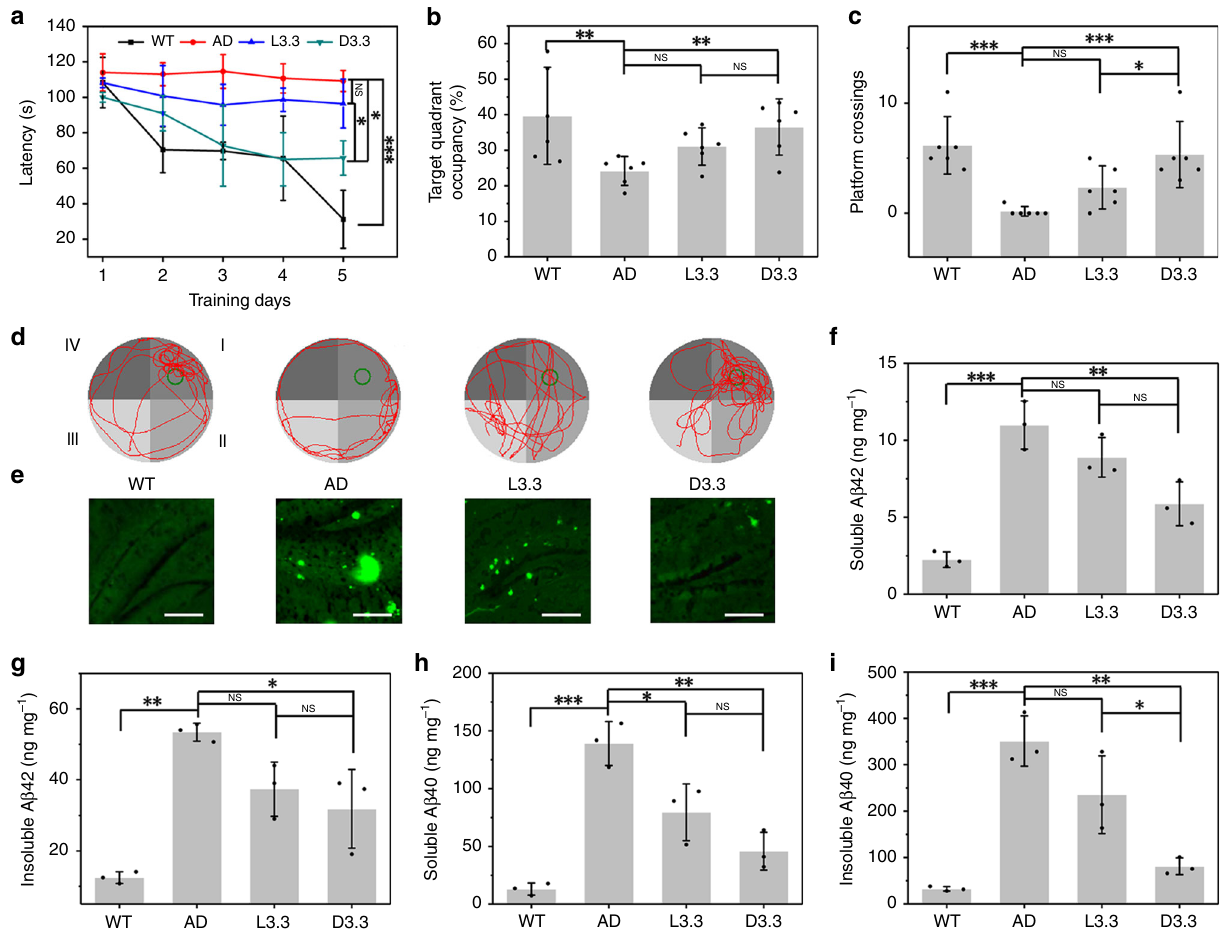
Fig. 5 Effect of L3.3 and D3.3 on rescuing memory impairments in AD model mice. a Latency for escape to platform in the training phase. b Percentage (%) of time spent in the target quadrant in probe test. c Number of crossing platform time in probe test. Error bars indicate the s.d. ( n = 6 mice per group). * P < 0.05; ** P < 0.01; *** P < 0.001; NS not signi fi cant; one-way ANOVA, followed by Holm-Sidak post hoc test. For detailed statistical analysis see Supplementary Tables 6 and 7. d Track of probe test. e Immuno fl uorescence for A β in the hippocampus of WT control mice, AD control mice, AD mice with L3.3 or D3.3 treatment. Scale bars, 200 μ m. f – i Soluble A β 42 ( f ), insoluble A β 42 ( g ), soluble A β 40 ( h ), and insoluble A β 40 ( i ) in the brains